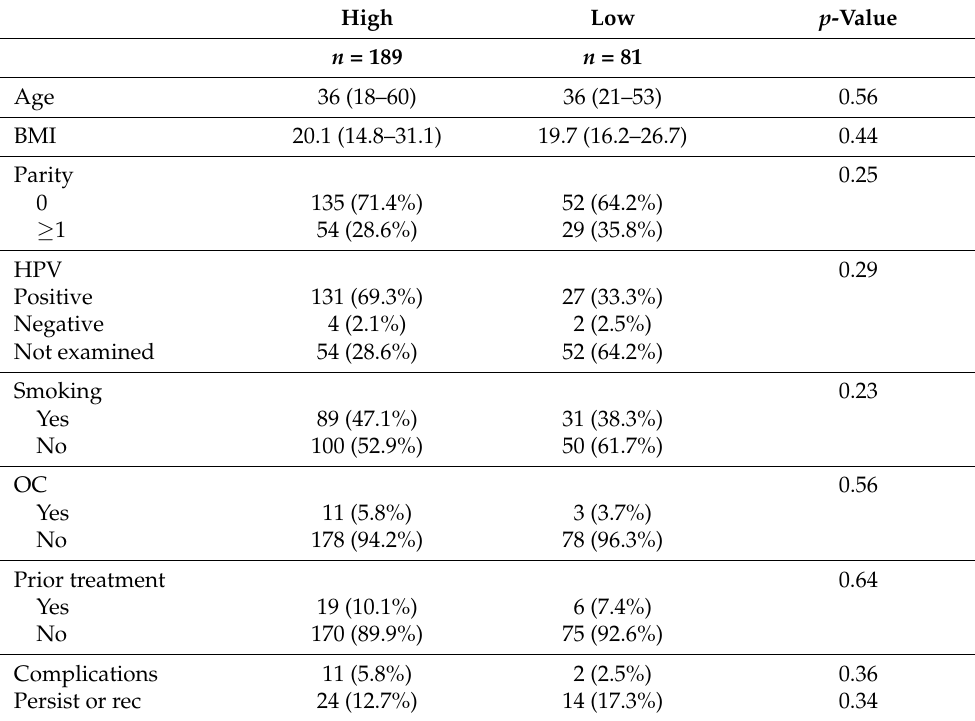
Table 3. Comparison of patients’ characteristics and treatment outcome according to surgeon